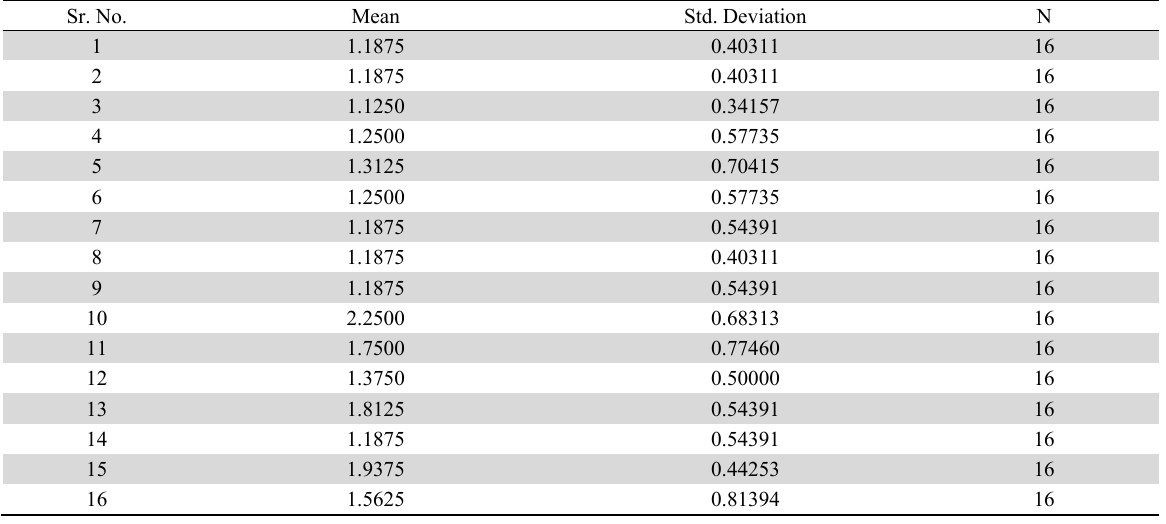
Scale Statistics Mean Variance Std. Deviation N of Items